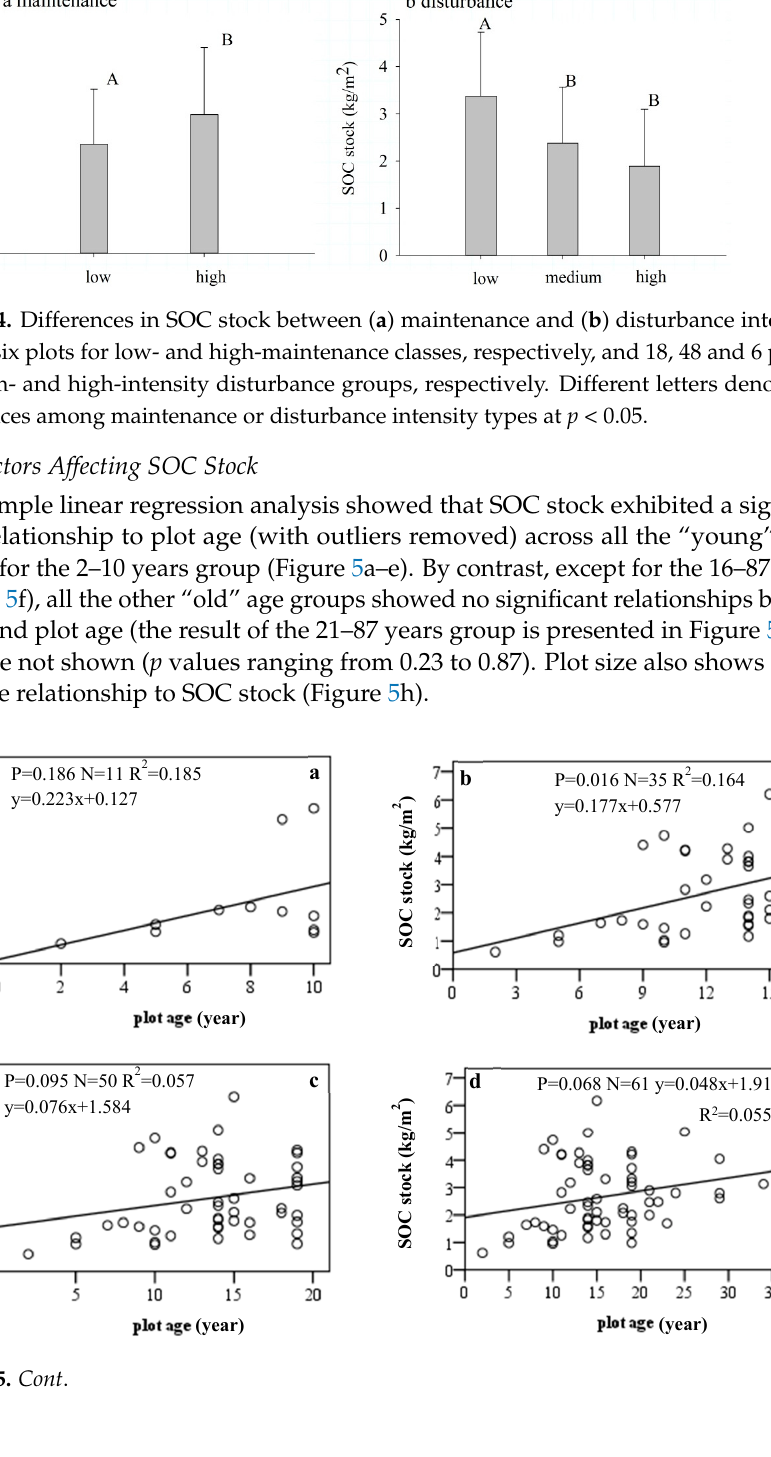
Figure 5. Relationship of stock (kg/m 2 ) to plot age (2–101 years) of age groups: 2–10 years ( a ), 2–15 years ( b ), 2–20 years ( c ), 2–35 years ( d ), and 2–87 years ( e ), 16–87 years ( f ), 21–87 years ( g ) and to plot size (63–2058 m 2 ) ( h ). Plots with older age but much lower SOC content were removed. A total of 1, 4, 7, 7 and 7 outliers were removed from the 2–20 years ( c ), 2–35 years ( d ), 2–87 years ( e ), 16–87 years ( f ) and 21–87 years ( g ) groups, respectively. The outliers removed from the former age group were also removed from the latter.